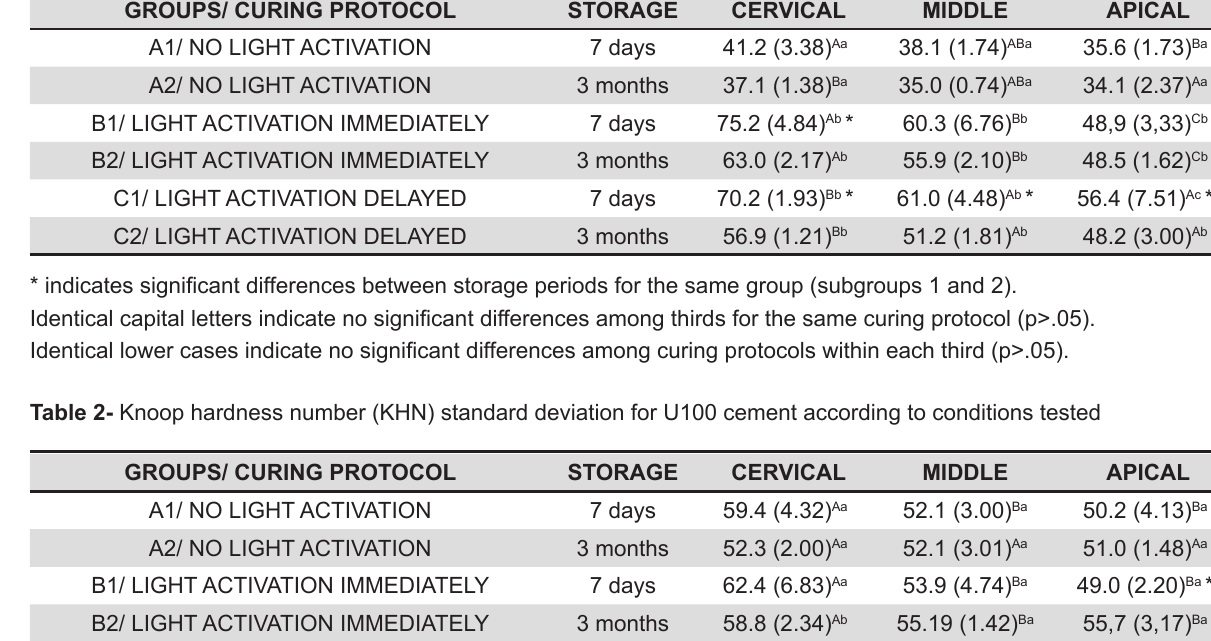
Table 1- Knoop hardness number (KHN) standard deviation for Panavia 2F cement according to conditions tested